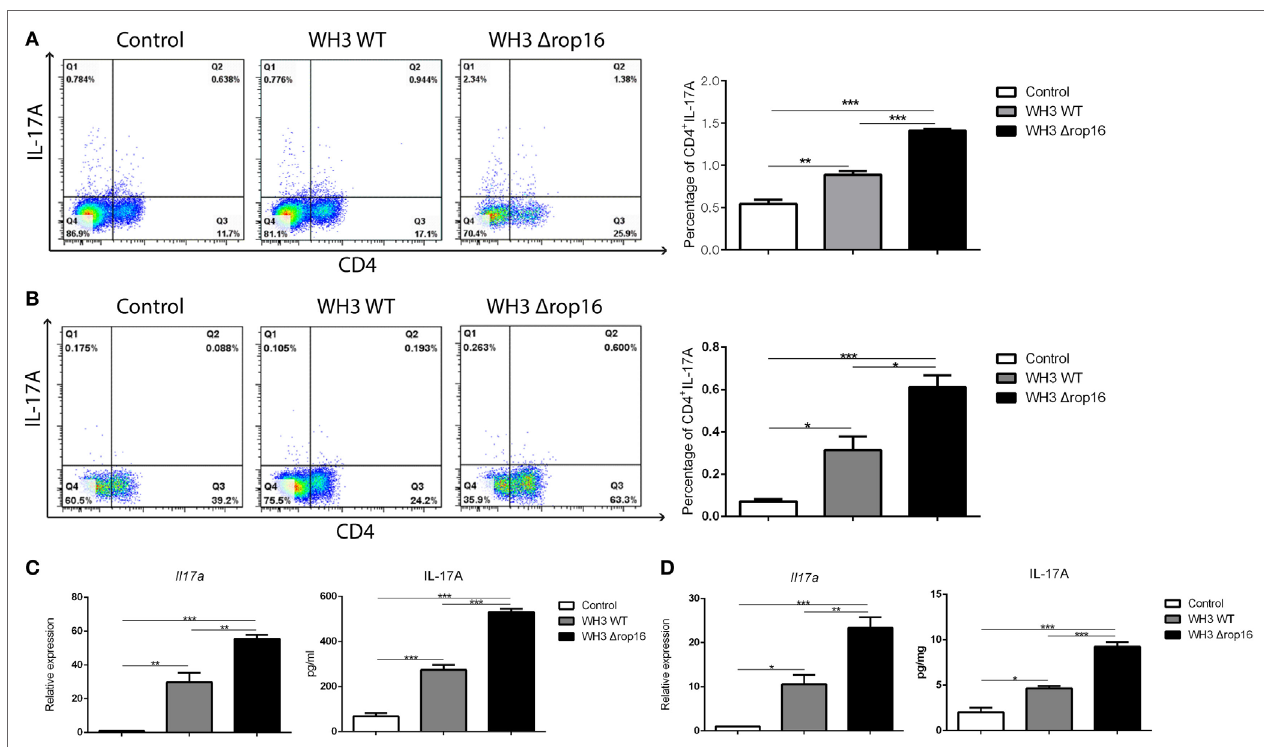
FigUre 5 | WH3 Δ rop16 strain infection upregulated Th17 response in the spleens and placentas of the pregnant mice. The mice infected with WH3 Δ rop16 strain expressed a high level of interleukin (IL)-17A in the spleens (a) and placentas (B) determined by flow cytometry. IL-17A mRNA expression in the animals infected with WH3 Δ rop16 in the spleens (c) and placentas (D) . The IL-17A in the supernatants of spleens (pg/ml) (c) and placentas (pg/mg) (D) confirmed by enzyme- linked immunosorbent assay (* p < 0.05,** p < 0.01,*** p <